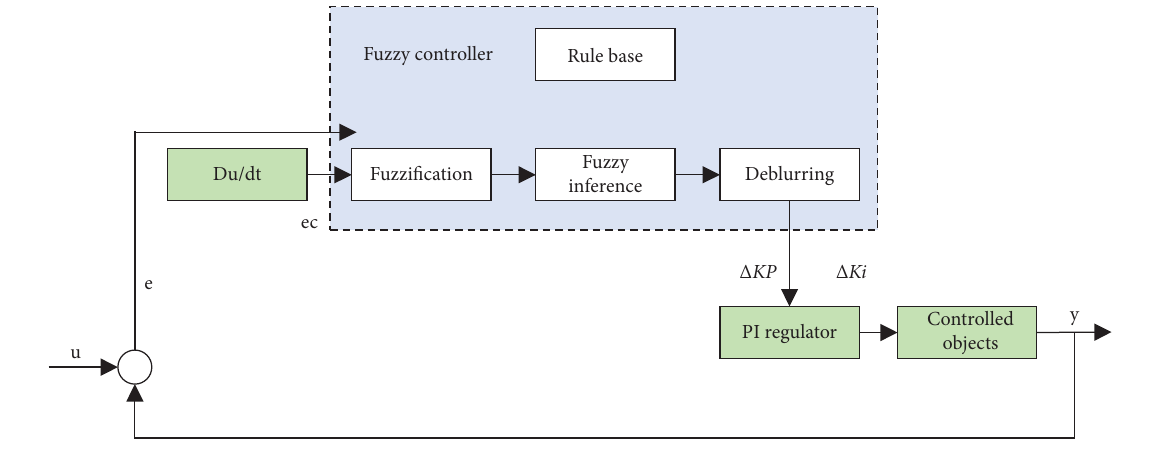
Figure 7: Structure of adaptive fuzzy PI